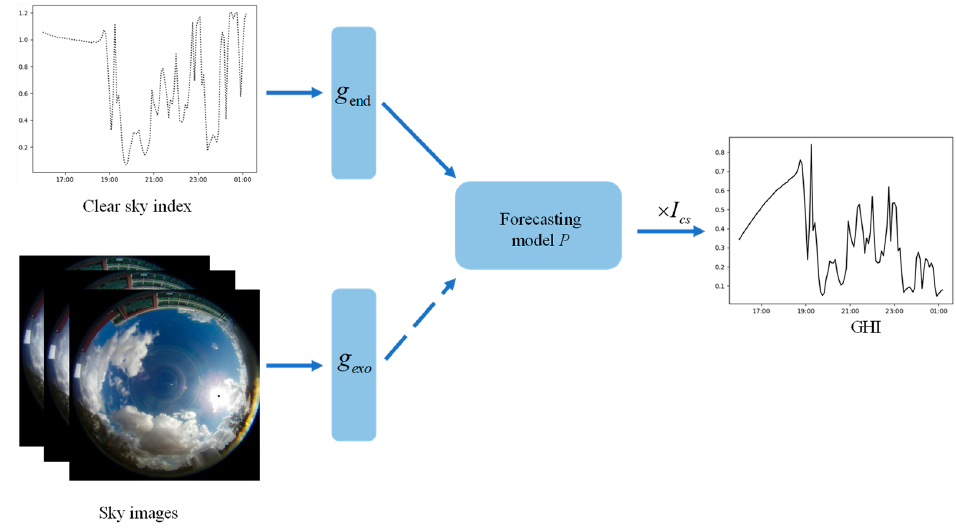
Figure 1. GHI forecasting framework. g exo and g end indicate feature engineering method applied on exogenous input and endogenous input respectively.